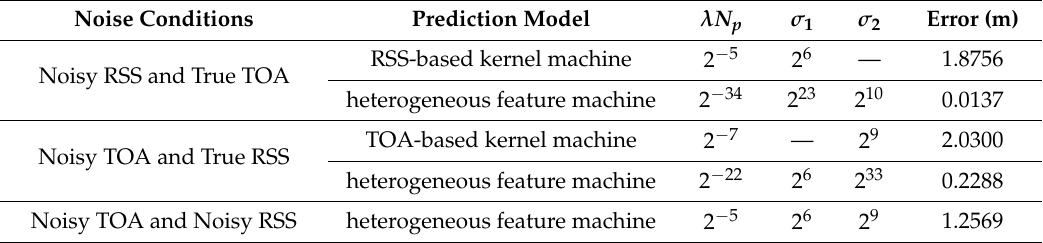
Table 4. Performance comparison of heterogeneous feature machine and single feature-based kernel machine learned by HFF-RR algorithms under noise